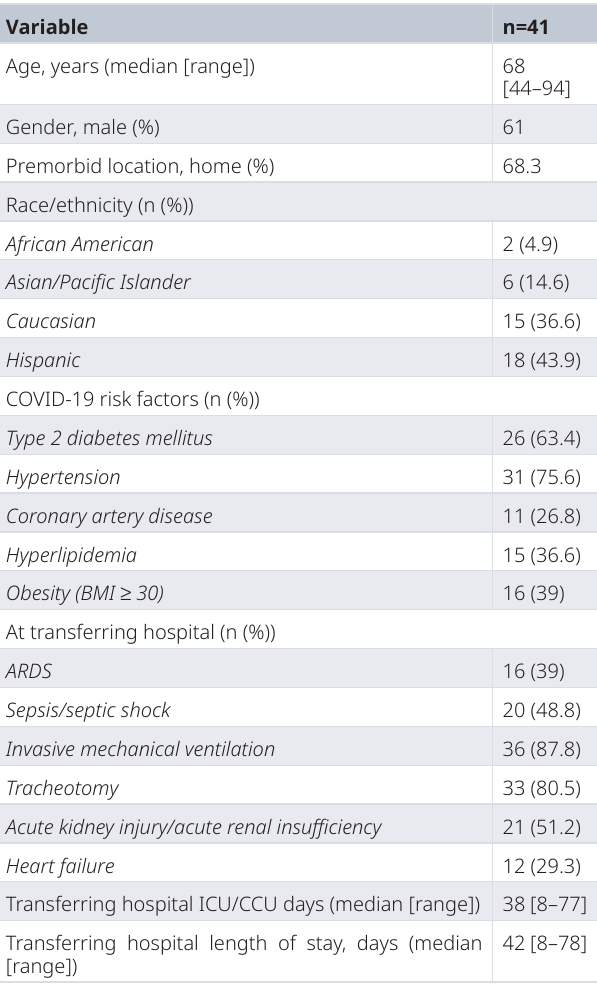
Table 1. Selected demographics and characteristics of patients admitted for post-COVID